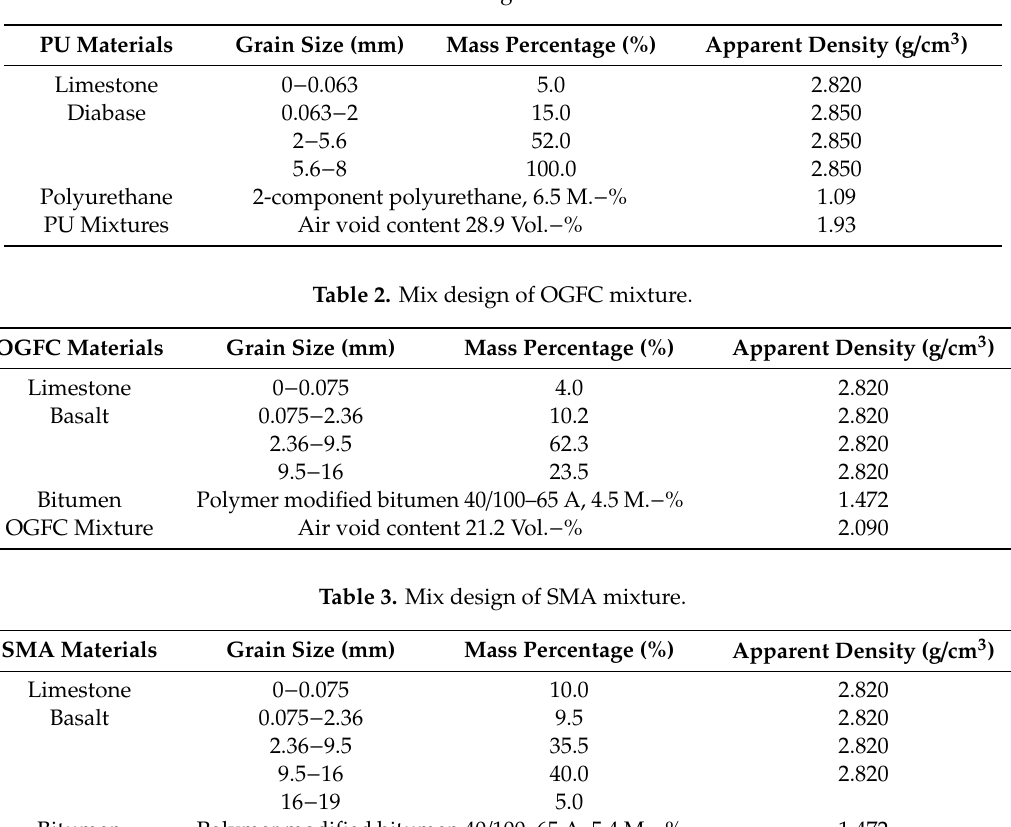
Table 1. Mix design of PU mixture.